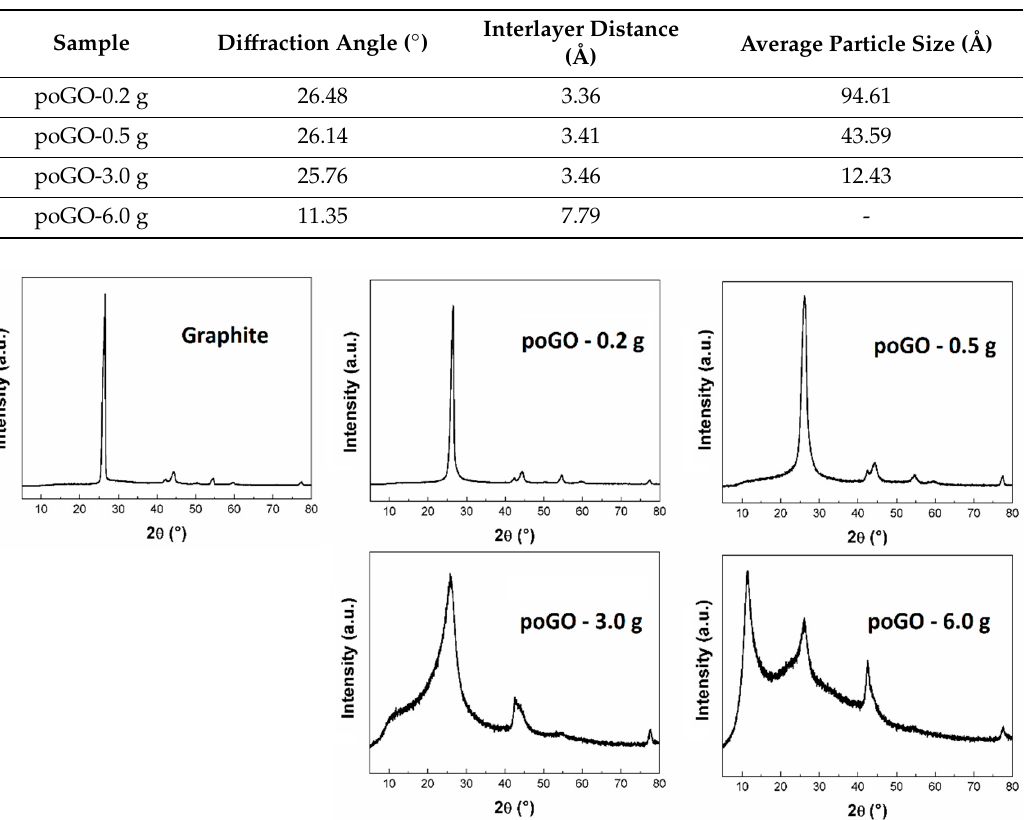
Figure 3. XRD measurements of poGOs.